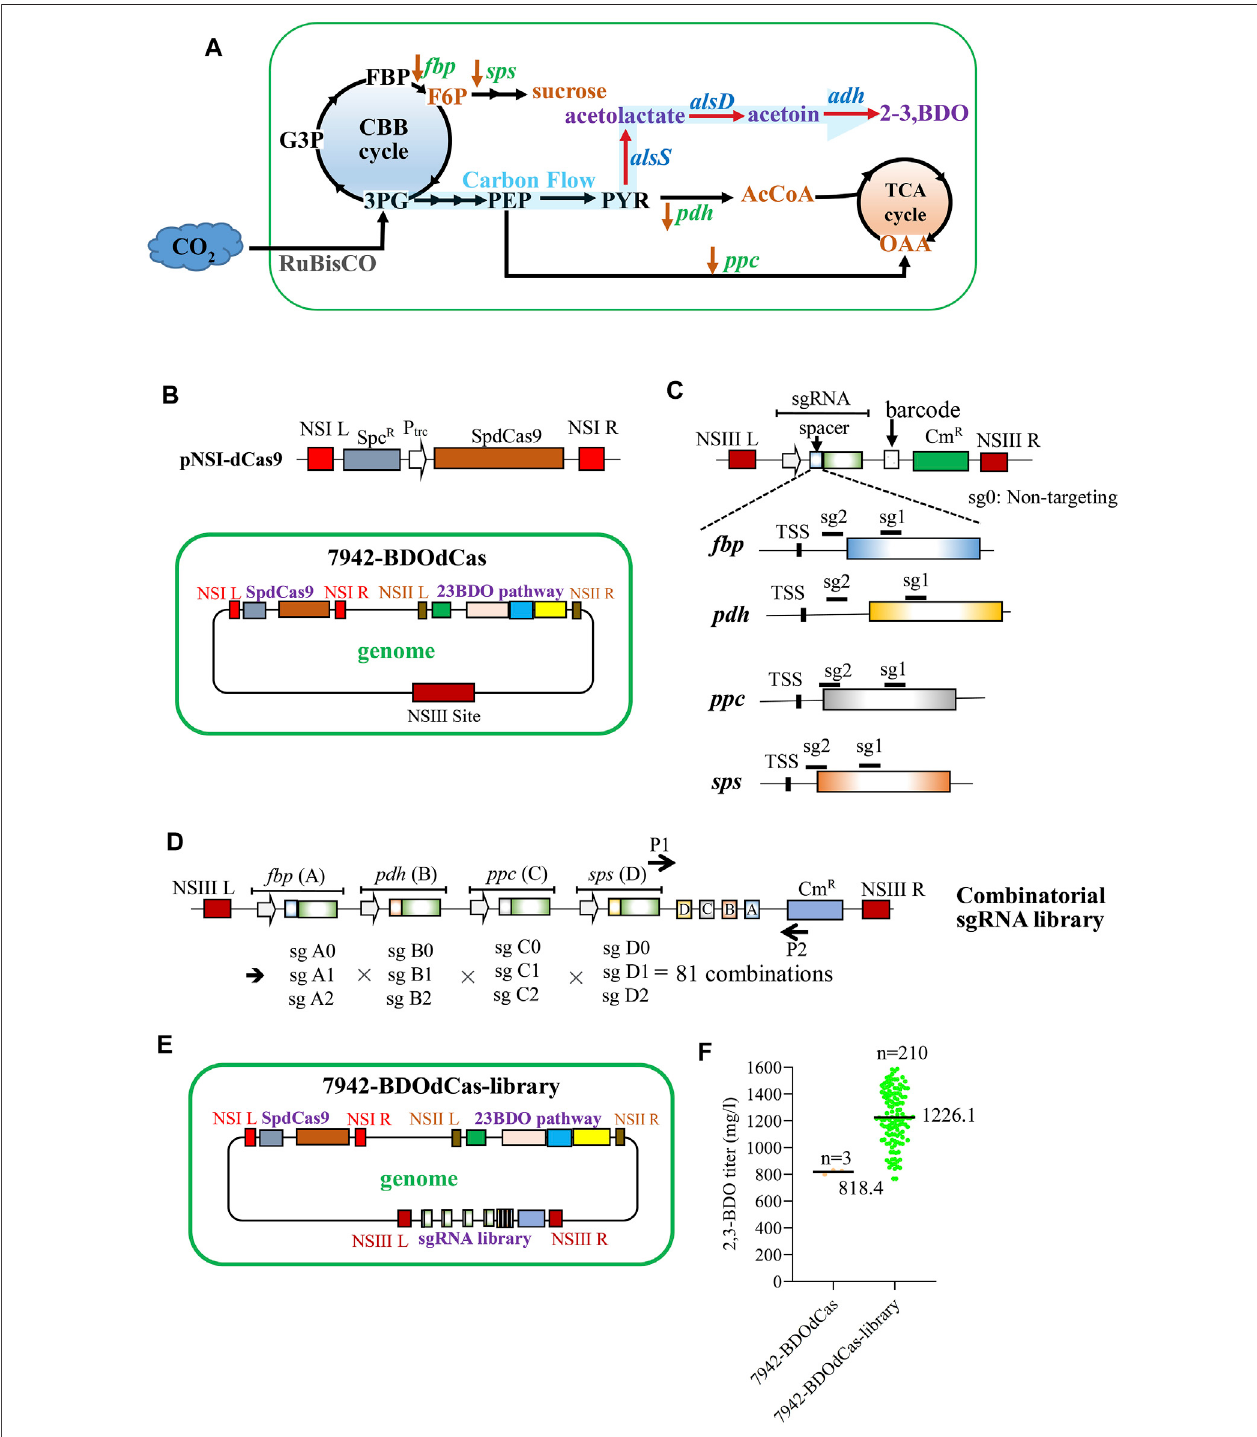
FIGURE 3 | Development of the CRISPRi library for enhanced 2,3-BDO production. (A) Pathways leading to the synthesis of desired 2,3-BDO and undesired metabolites. AcCoA, acetyl-coenzyme A; OAA, oxaloacetate; F6P, fructose-6-phosphate; FBP, fructose-1,6-bisphosphate; fbp , fructose bisphosphatase; pdh , pyruvate dehydrogenase; ppc , phosphoenolpyruvate carboxylase; and sps , sucrose phosphate synthase. (B) Plasmid encoding SpdCas9 and the engineered 7942- BDOdCasstrain.7942-BDOdCasstrainwasengineeredusingSaCas9tointegrateSpdCas9intoNSIand2,3-BDOpathwaygenesintotheNSIIsite. (C) Plasmids encoding the sgRNA and unique barcode. The sgRNA spacer wasdesigned to target the protospacer downstream the transcription start site (TSS) of fbp , pdh , ppc , or sps (sg1orsg2)withthehighesttargetingscores.WealsodesignedaplasmidencodingthescrambledsgRNAcomprisinganontargetingspacer(sg0). (D) Illustrationof